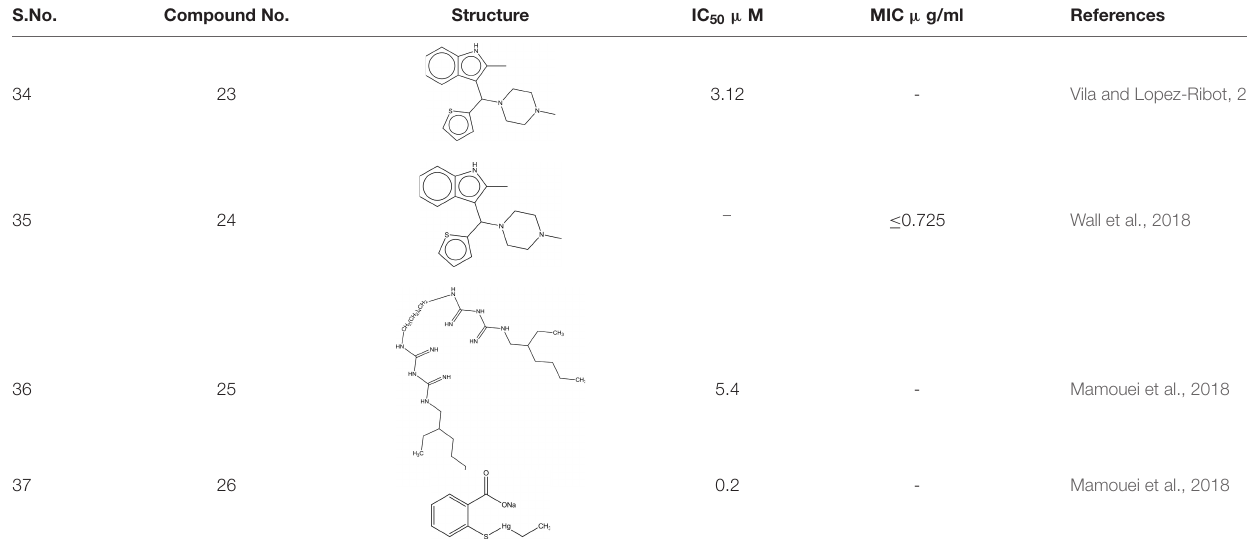
TABLE 2 | Chemical structures and MIC/IC 50 values of small molecule inhibitors (23–26).